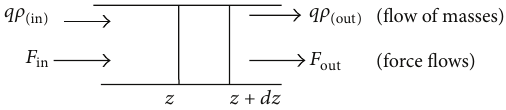
Figure 1: A typical pipeline